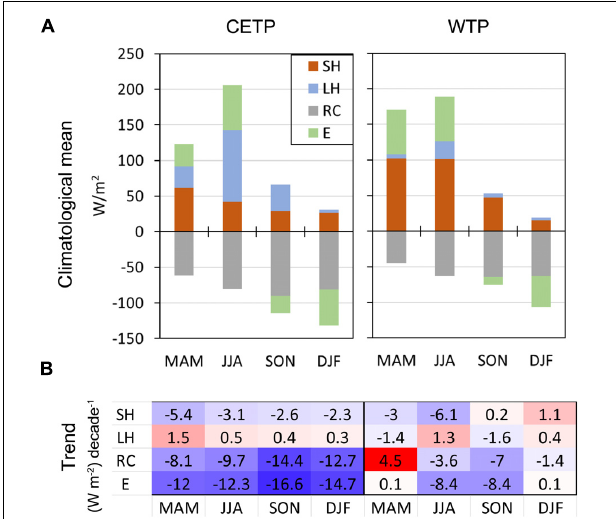
FIGURE 1 | Characteristics of diabatic heating over Tibetan Plateau (TP). (A) Climatological mean (1984–2003) of surface sensible heat (SH), latent heat (LH) released to the atmosphere by precipitation, net radiation flux (RC) of the air column, and atmospheric heat source/sink (E) over the central and eastern TP and western TP. (B) Trend of atmospheric heat source/sink and its components. This figure is based on the data from Duan and Wu (2008).